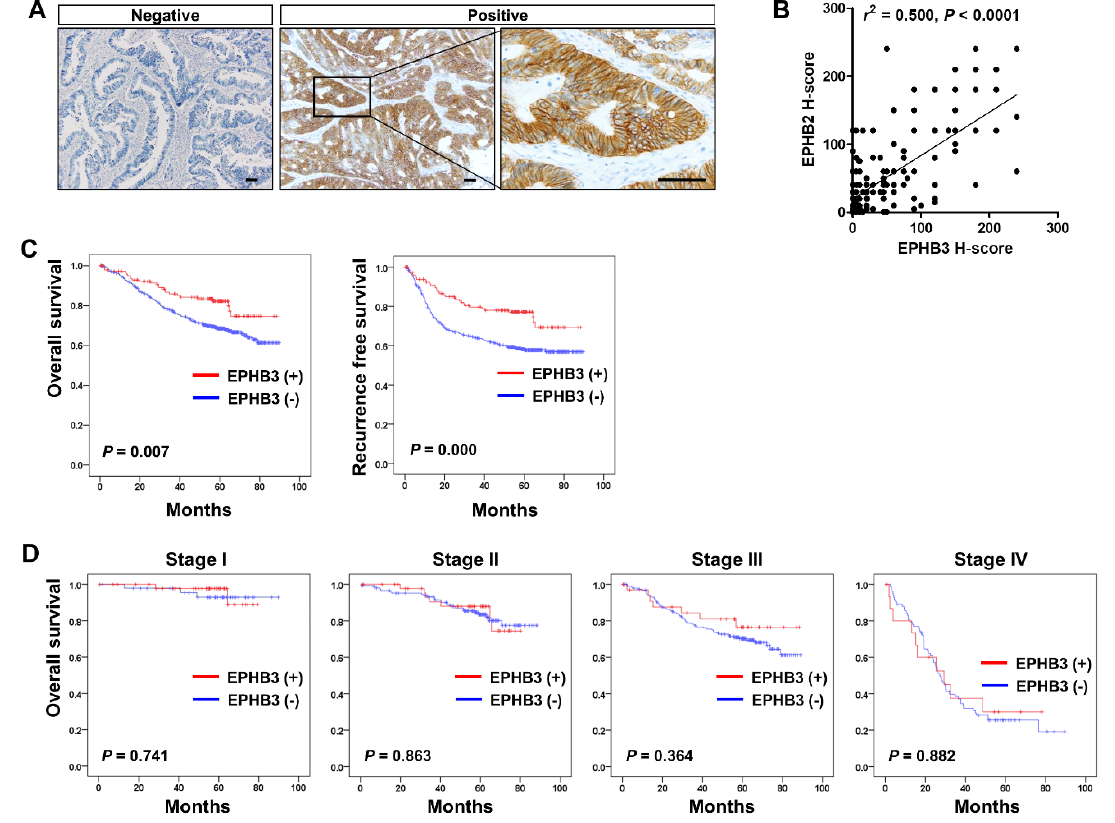
Figure 6. There is a positive correlation between EPHB3 expression and better clinical outcomes of patients with colorectal cancer (CRC). Immunohistochemistry for EPHB3 was performed in a large cohort of CRCs ( n = 610). ( A ) Representative cases of CRCs that are negative or positive for EPHB3. ( B ) There was a strong correlation in the H-scores of EPHB2 and EPHB3. ( C ) Kaplan–Meier analysis demonstrated that EPHB3 positivity showed better overall ( p = 0.007) and recurrence-free ( p = 0.000) survival rates. ( D ) Prognostic significance of EPHB3 expression was more apparent in stage III CRC patients. Scale bars: 50 µ